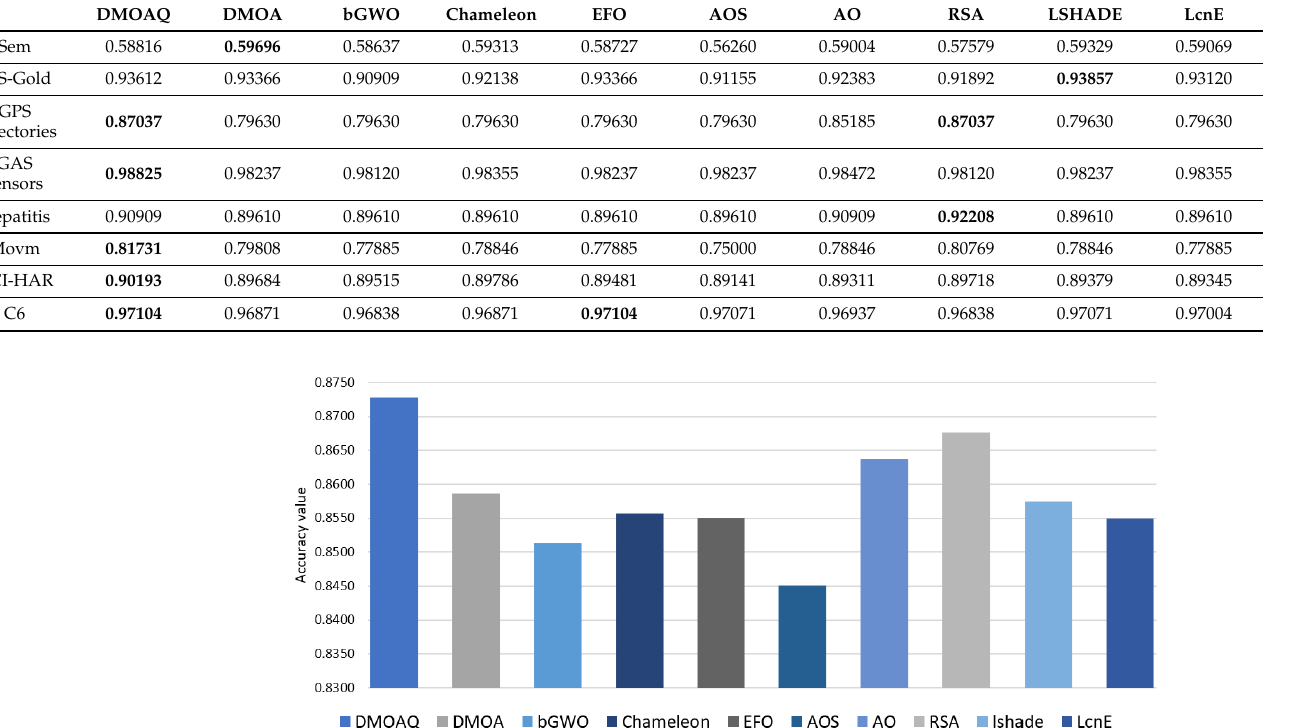
Table 11. Accuracy obtained from competitive algorithm for all datasets.